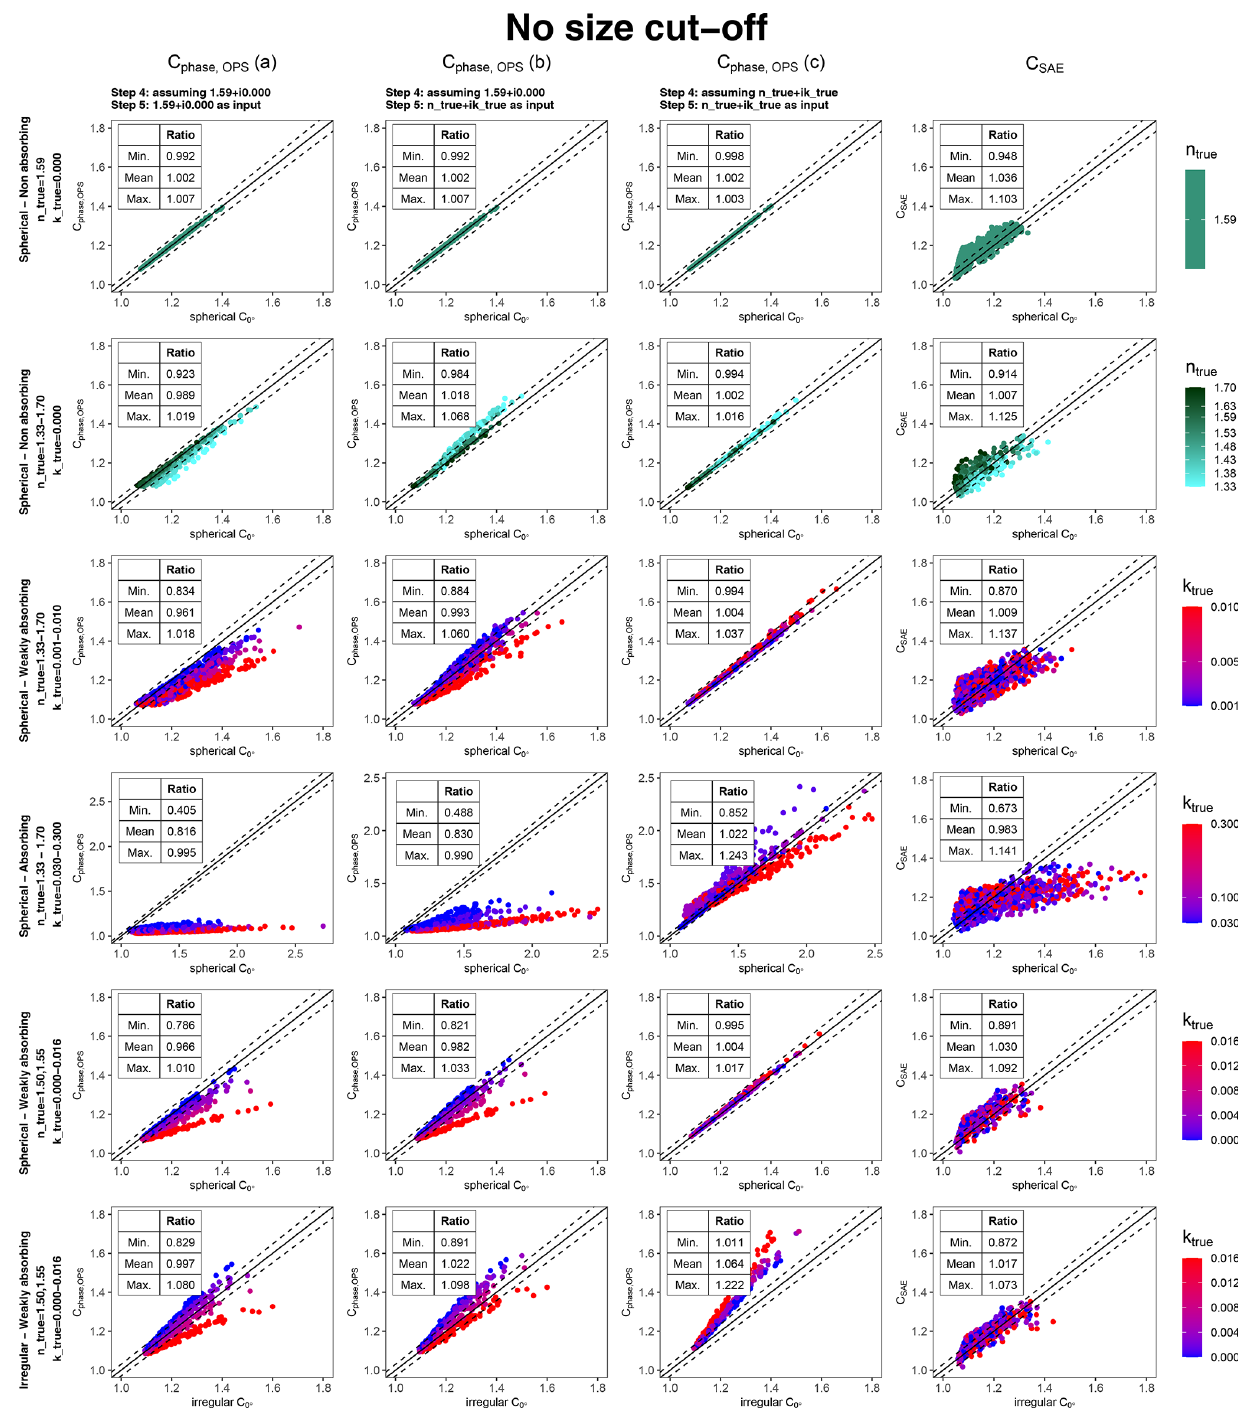
Figure 7. Simulated closure experiment to assess the limitations and uncertainties of the angular correction obtained with Mie theory from the size distribution measured by an OPS. The comparisons for the angular correction C phase , OPS calculated with the three approaches (a, b, c) are shown in the first three columns. The comparison for the angular correction C SAE is reported in the last column for comparison. Different rows refer to different aerosol input. The color code indicates different values of the real part of the refractive index for the non absorbing cases (rows 1–2) and of the imaginary part of the refractive index for all the other cases (rows 3–6). The solid lines are the 1:1 lines. The dashed lines are the ± 3% lines. The minimum, mean, and maximum value of the ratio between the quantity reported on the y axis and the quantity reported on the x axis is reported in the tables. Calculations are limited for computational purposes to particle diameter ranges of 0.3–10 and 0.3–5.8µm for homogeneous spherical particles and for irregular